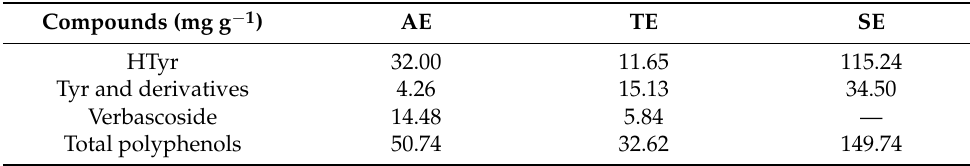
Table 1. Characterization of the OPWPs extracts by HPLC/DAD.